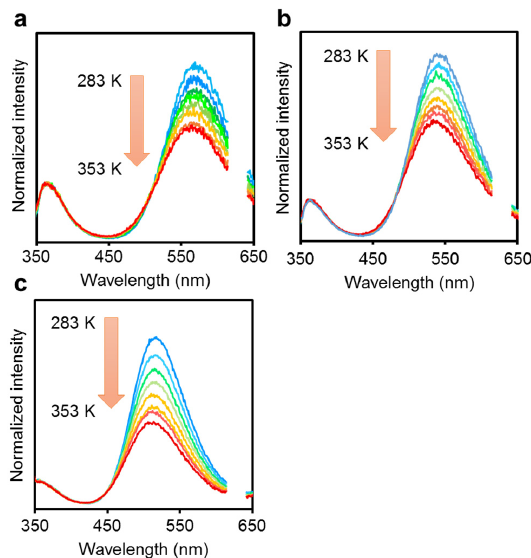
Figure 4. Variable temperature photoluminescence (PL) spectra of (a) 1B , (b) 2B and (c) 3B in octane (1.0 × 10 − 5 M) from 283 to 353 K. Light scattering from the incident light at around 620 nm was omitted in the spectra.